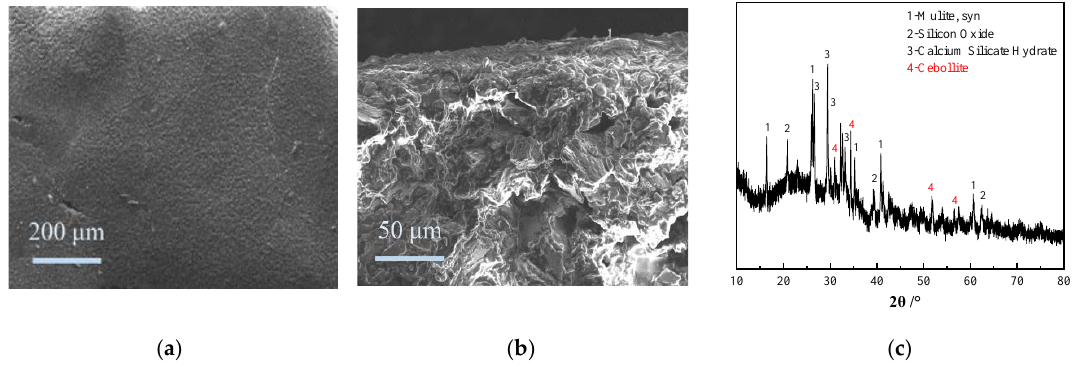
Figure 12. SEM and XRD analyses of the base coating. ( a ) SEM image of coating surface; ( b ) SEM image of coating cross-section; ( c ) XRD pattern of coating.